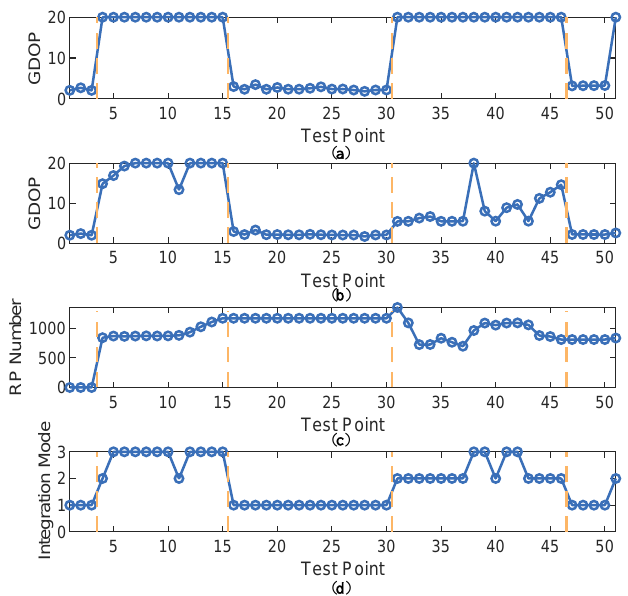
Figure 9. The inputs and output of the fuzzy inference system at Site 1: ( a ) GDOP of GPS-only mode; ( b ) GDOP of GPS + DTMB; ( c ) the number of RPs within constraint range; and ( d ) integration